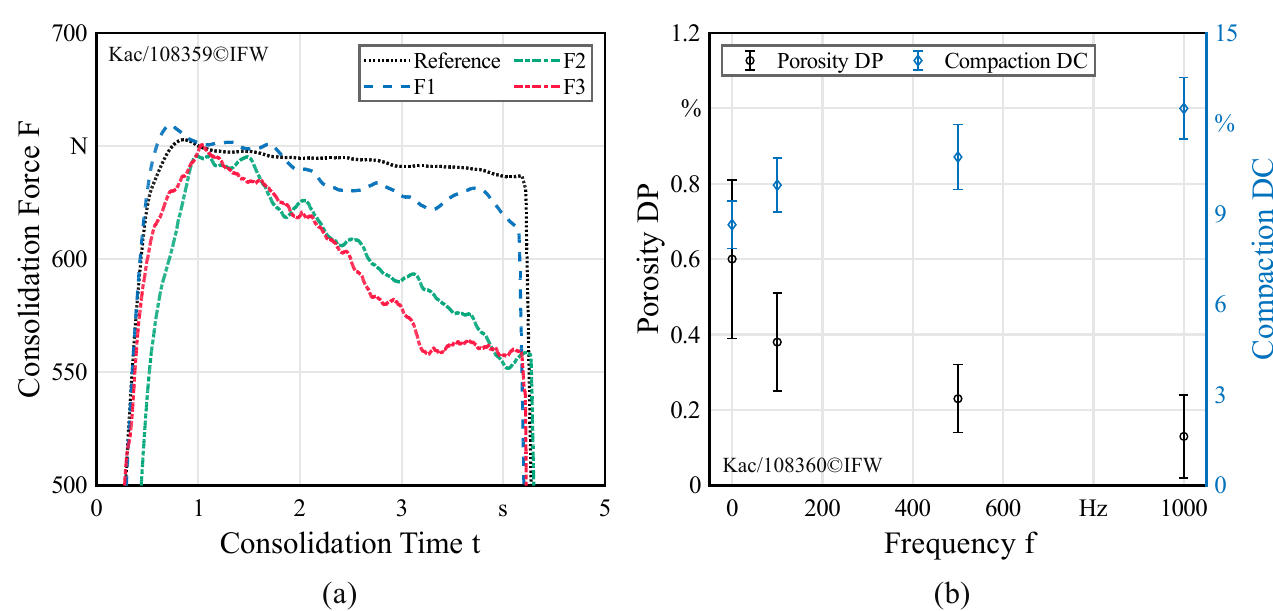
Figure 3. ( a ) Measured static consolidation force in relation to the consolidation time for the varied excitation frequencies; ( b ) Degree of Porosity (DP) and Degree of Compaction (DC) in relation to the varied excitation frequencies determined by Laser Scanning Microscopy.